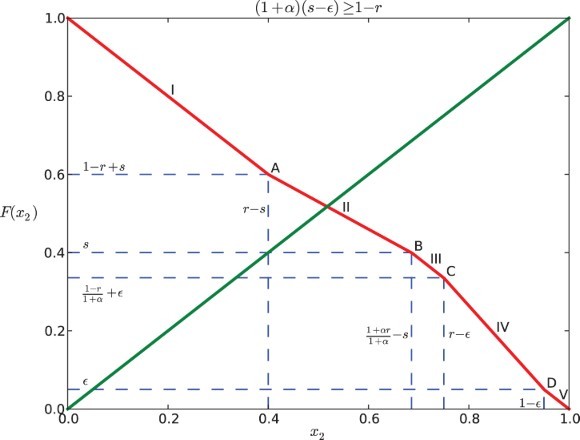
Return map F for Case II when α=−0.3, s=0.4, r=0.8, and ε=0.05.